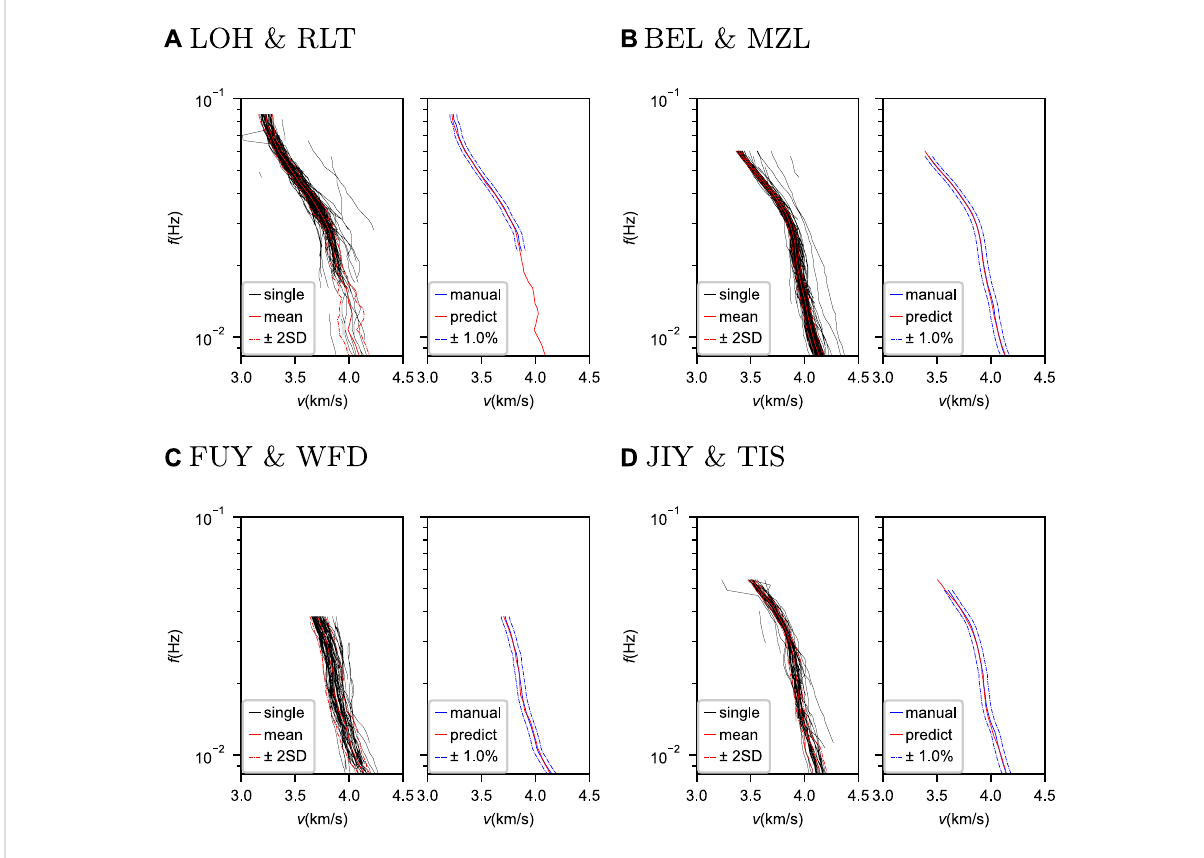
FIGURE 7 Comparisons between the predicted dispersion curves by Surf-Net and manual results for four station pairs. In each sub fi gure (A – D) , the left oneshowsthepredictedsingle(blacklines)andaverage(solidredlines)dispersioncurveswith2timesthestandarddeviations(dashedredlines),and the right one shows the predicted (red line) and manual (solid blue line) average dispersion curves with a 1% perturbation (dashed blue lines).